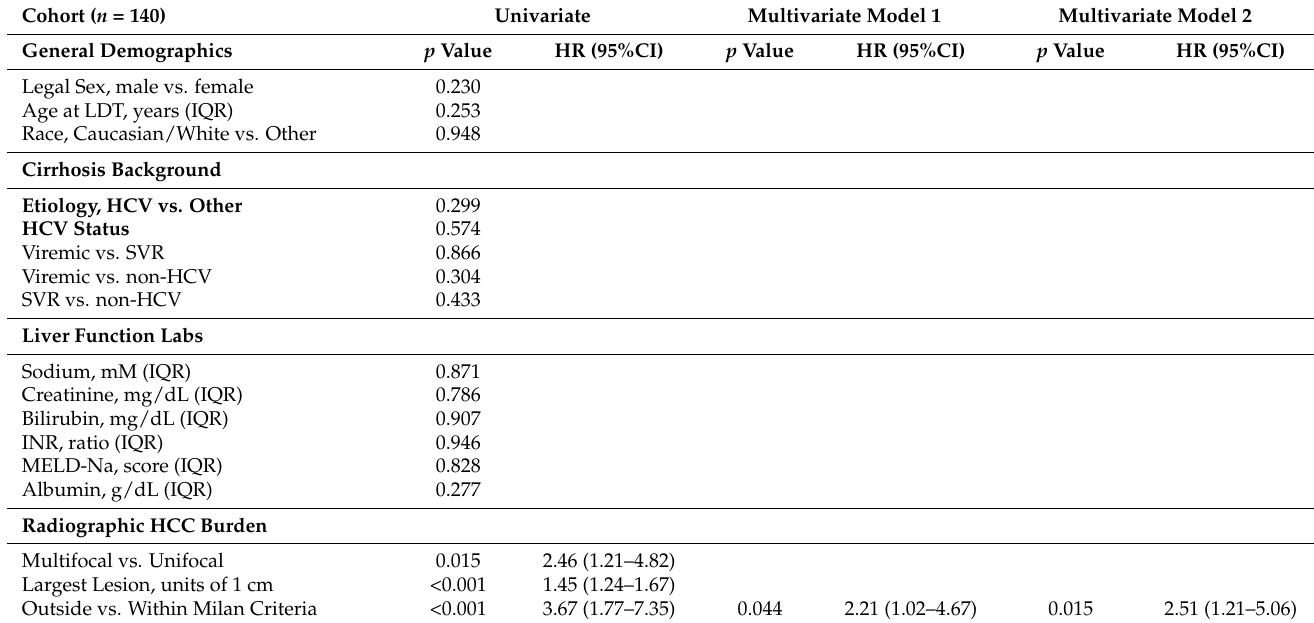
Table 5. Univariate Analysis of AFP, AFP-L3%, and DCP with Bridge to Transplant Outcome of HCC Progression after Liver-Directed